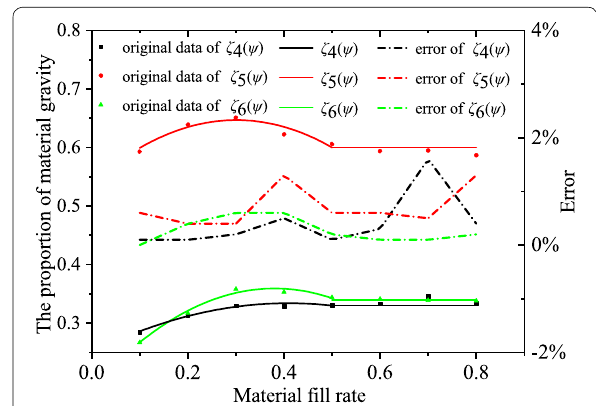
Figure 4 The fitting functions of ζ i ( ψ ) and their